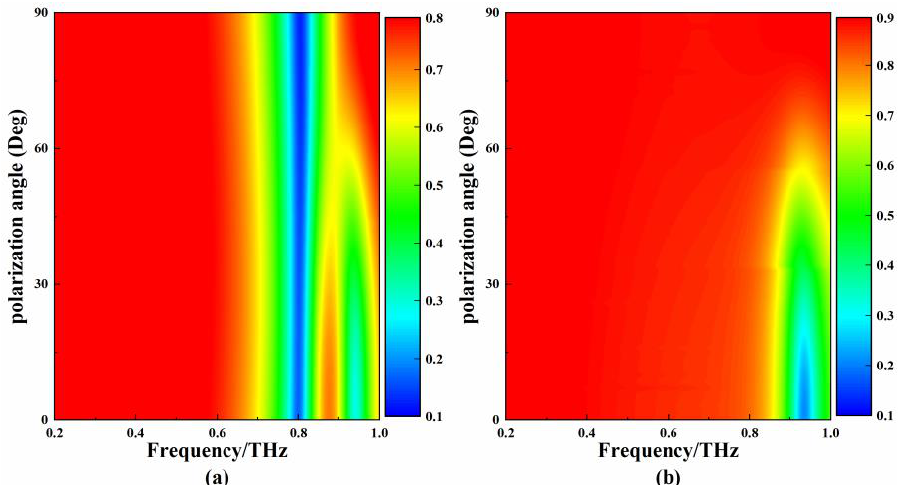
Figure 4. ( a ) The transmission curves of EIT-like MM corresponding to different polarization angles; ( b ) the transmission curves of SDLS corresponding to different polarization angles.